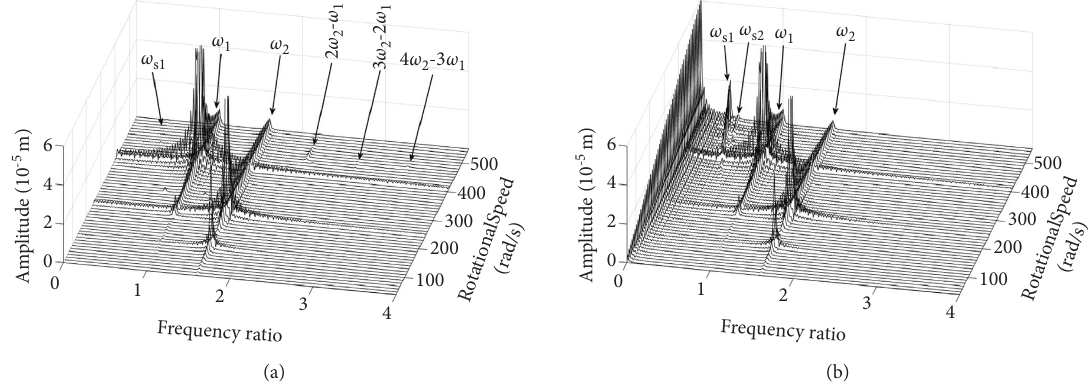
Figure 8: Waterfall spectrum plots for the lateral vibration of disk 4 in vertical direction. (a) Level flight. (b) Hovering flight.